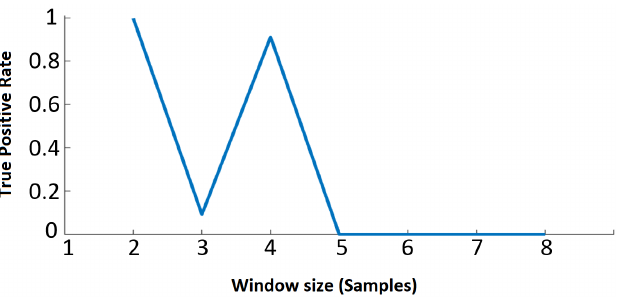
Figure 4. True positive rate by varying window sizes for the calculation of PLV.